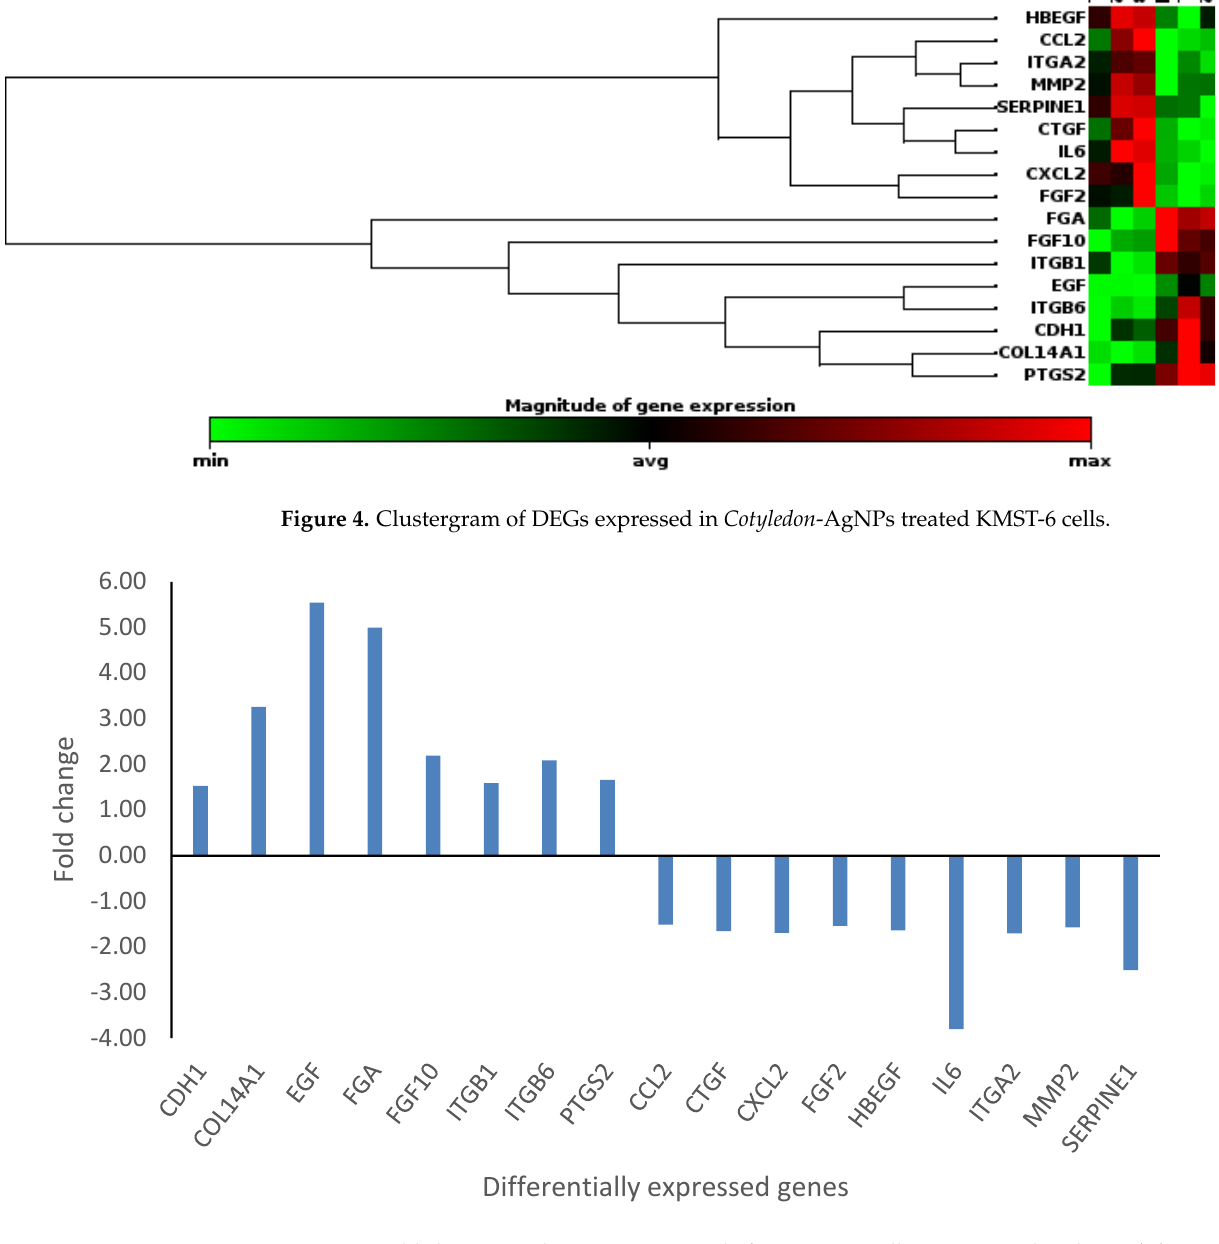
Figure 5. Fold changes in the DEGs expressed after KMST-6 cells were treated with Cotyledon -AgNPs. Genes with a fold change of ≥±1.5 and p -values of <0.05 were considered DEGs.